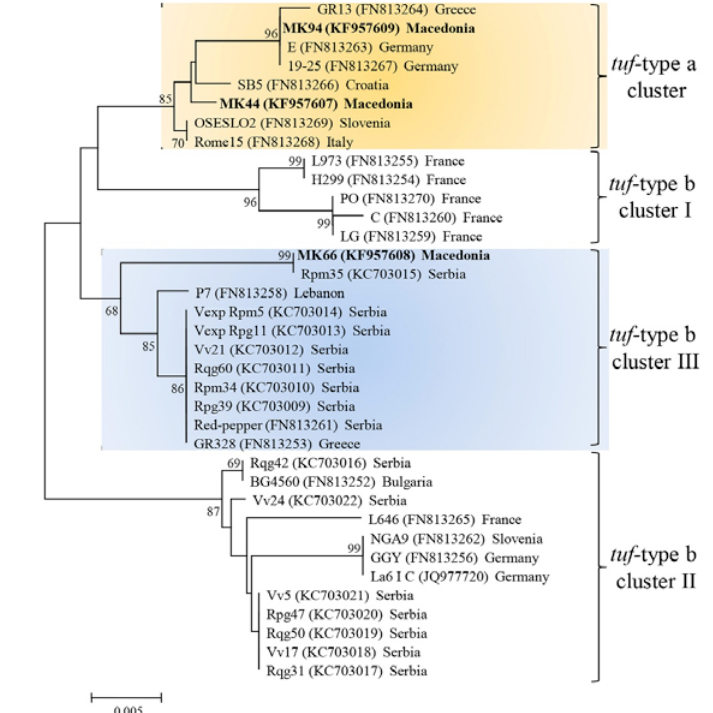
Figure 6. Unrooted phylogenetic tree inferred from ‘ Ca . P. solani’ strain nucleotide sequences of gene stamp . Minimum evolution analysis was carried out using the neighbor-joining method and bootstrap replicated 1,000 times.Names of phytoplasma strains included in phylogenetic analysis are written on the tree image. GenBank accession number of each sequence is given in parenthesis; gene sequences obtained in the present study are indicated in bold characters. Clusters encompassing bois noir phytoplasmas from the present study are shown as colored